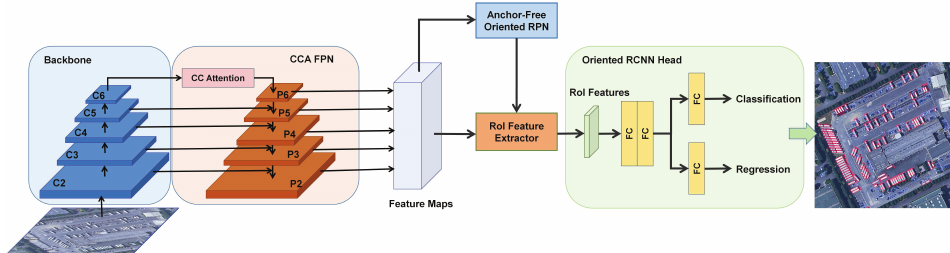
Figure 3. Overall architecture of the proposed method. There are four modules: backbone, Criss-Cross Attention FPN, anchor-free oriented RPN, and oriented RCNN